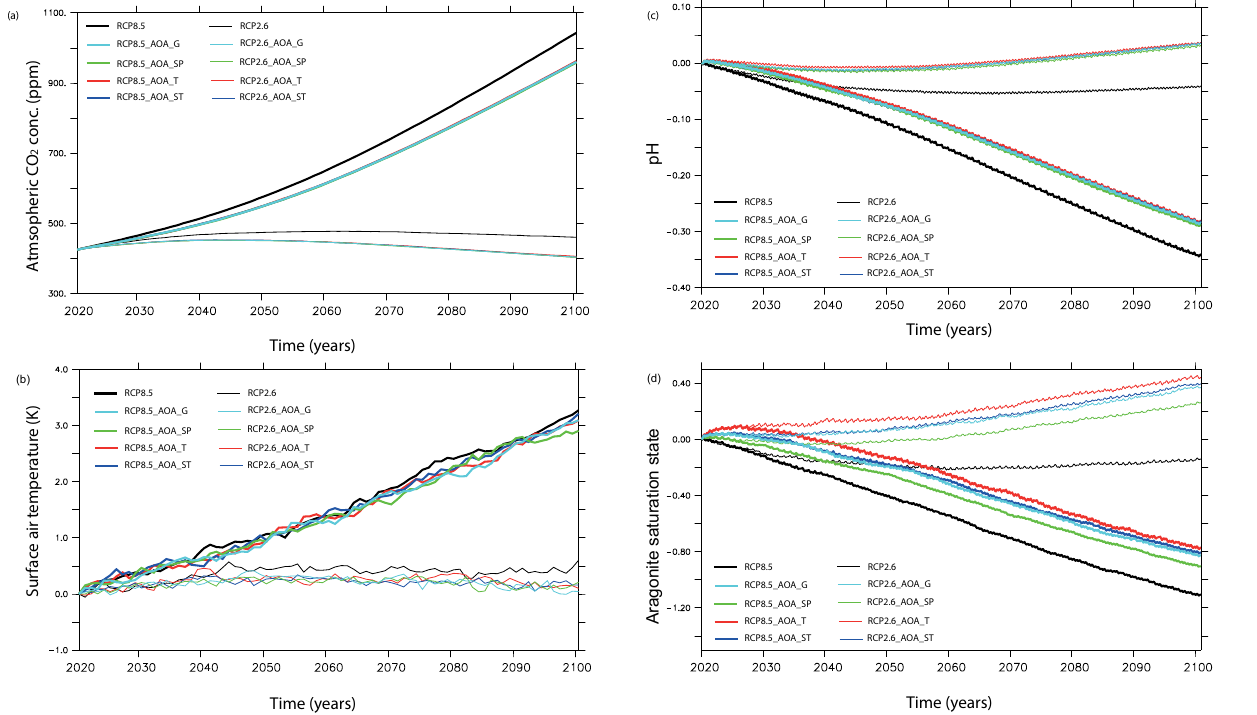
Figure 2. The global mean changes in: atmospheric CO 2 concentration (a) , surface air temperature (SAT; b ), surface ocean pH (c) , and aragonite saturation state (d) , for high (RCP8.5) and low emissions (RCP2.6) with global and regional AOA in the period